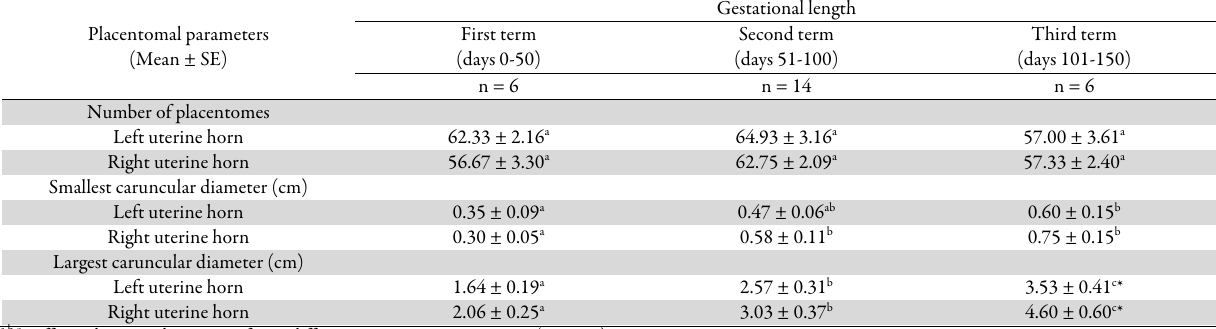
Asterix (*) within a column indicates significant differences between the left and right values (p < 0.05).